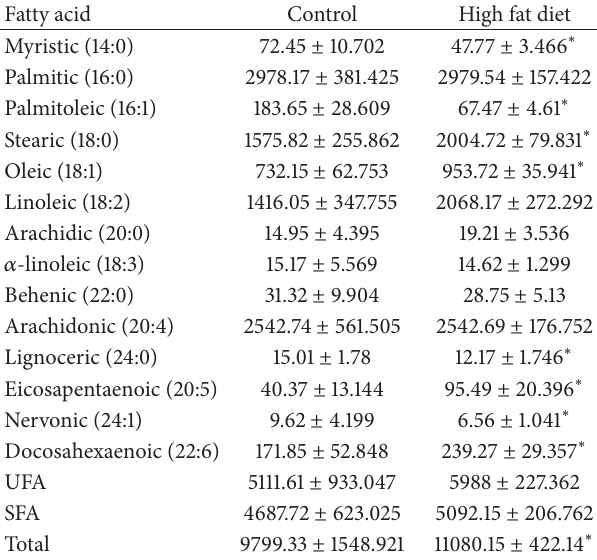
Table 9: Triacylglycerols composition in the submandibular sali- vary glands